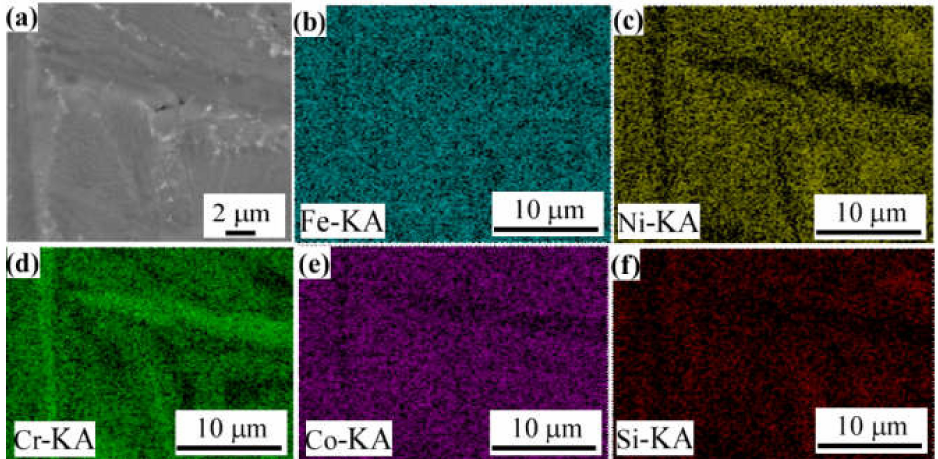
Figure 6. Elemental distribution of the FeCoNiCrBSiY coating. ( a ) cross-sectional morphology; ( b ) Fe; ( c ) Ni; ( d ) Cr; ( e ) Co; ( f )